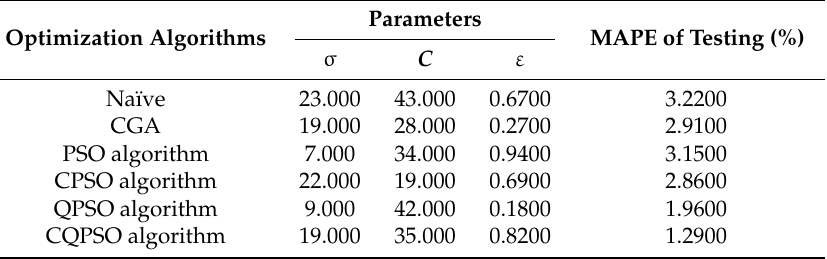
Table 6. Parameters determination of SVRCQPSO and SVRQPSO models (example three).